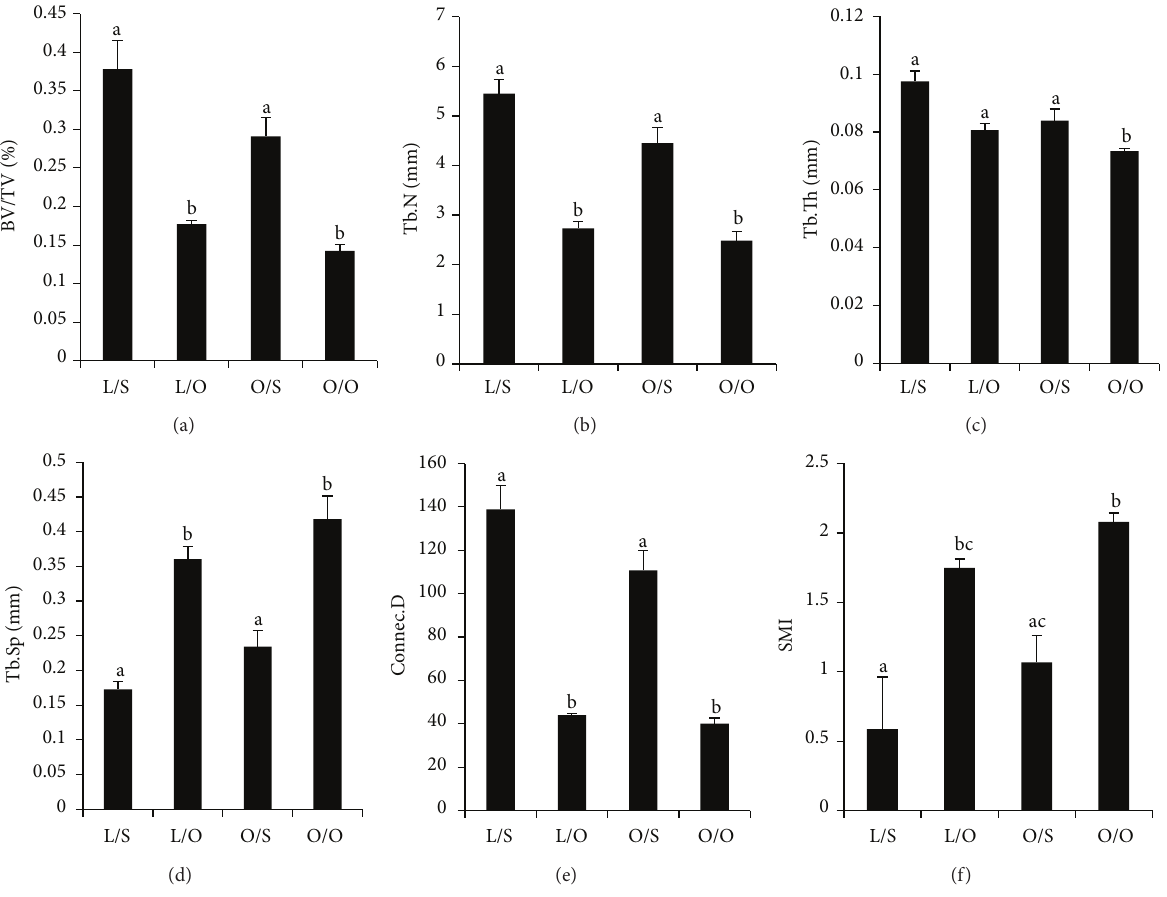
Figure 1: Effects of obesity and ovariectomy on tibial 𝜇 CT parameters in Zucker rats. Values are expressed as mean ± SEM. Values that do not share the same superscript letters are significantly ( 𝑃 < 0.05 ) different from each other. 𝑛 = 6 rats/group. L/S, lean ( 𝐿𝑒𝑝𝑟 𝑓𝑎/+ ) sham- operated; L/O, lean ( 𝐿𝑒𝑝𝑟 𝑓𝑎/+ ) ovariectomized; O/S, obese ( 𝐿𝑒𝑝𝑟 𝑓𝑎/𝑓𝑎 ) sham-operated; and O/O, obese ( 𝐿𝑒𝑝𝑟 𝑓𝑎/𝑓𝑎 ) ovariectomized. (a) BV/TV bone volume as percentage of tissue volume, (b) Tb.N trabecular number, (c) Tb.Th trabecular thickness, (d) Tb.Sp trabecular separation, (e) Conn.D connective density, and (f) SMI structure model